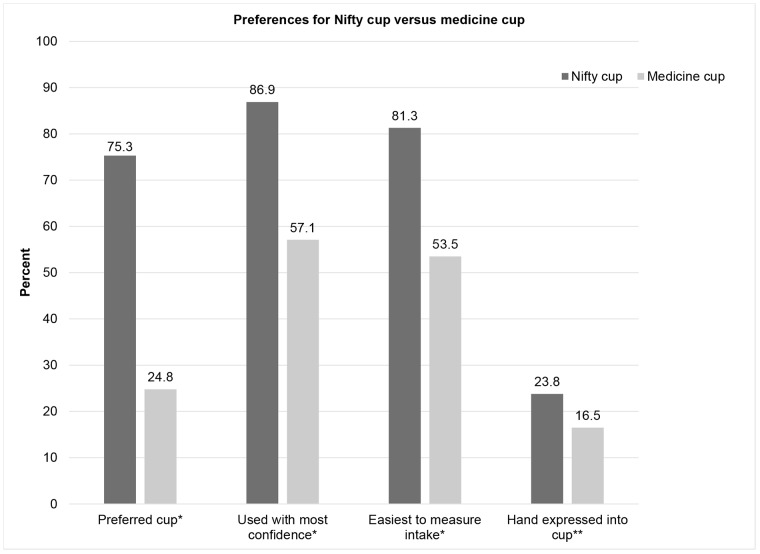
Preferences for Nifty cup versus medicine cup.*p < 0.001, **p < 0.01, among the 177 who reported hand expressing at baseline.